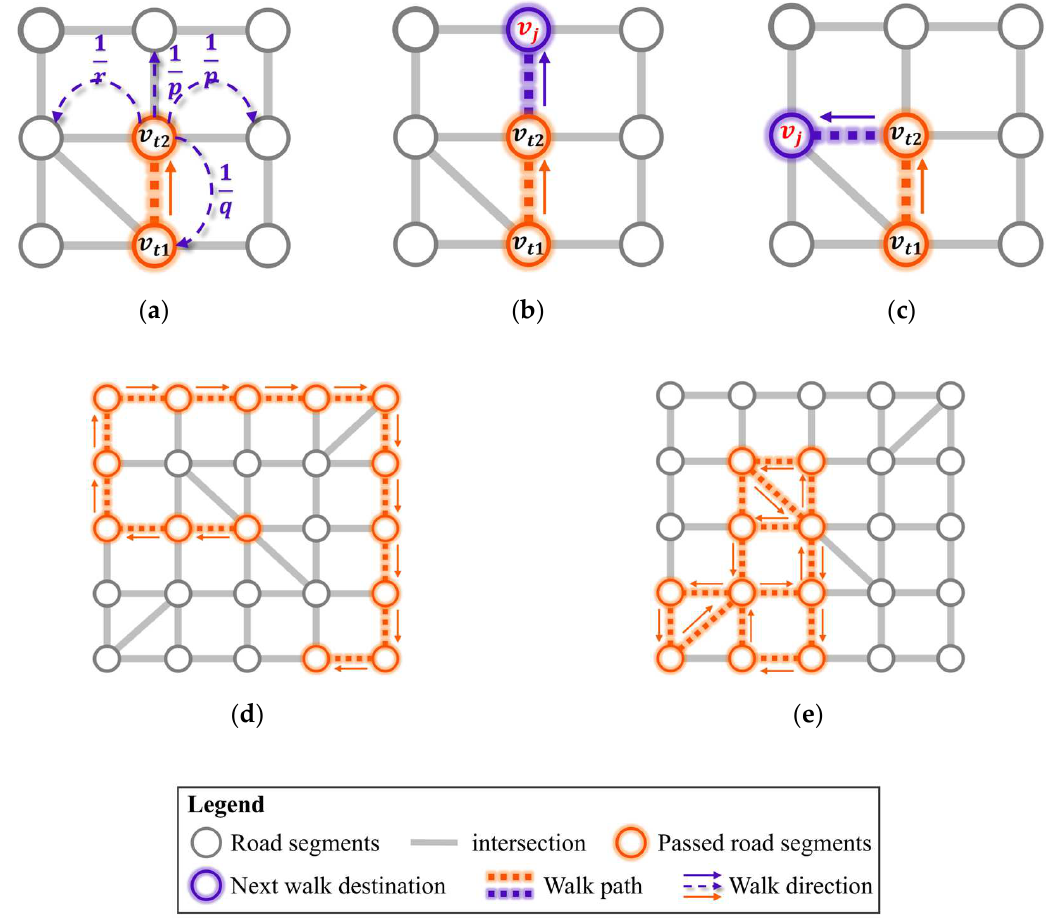
Figure 4. Illustration of the adjustment matrix W ( Π ) in the walk process via hyperparameters p , q , and r : ( a ) The role of these three hyperparameters in determining the next walk destination; ( b ) a walk sequence case in which the q and r values are large; ( c ) a walk sequence case in which the q and r values are small; ( d ) depth-first traversal can capture path features from origin to destination; ( e ) breadth-first traversal can capture more global and local structural features.